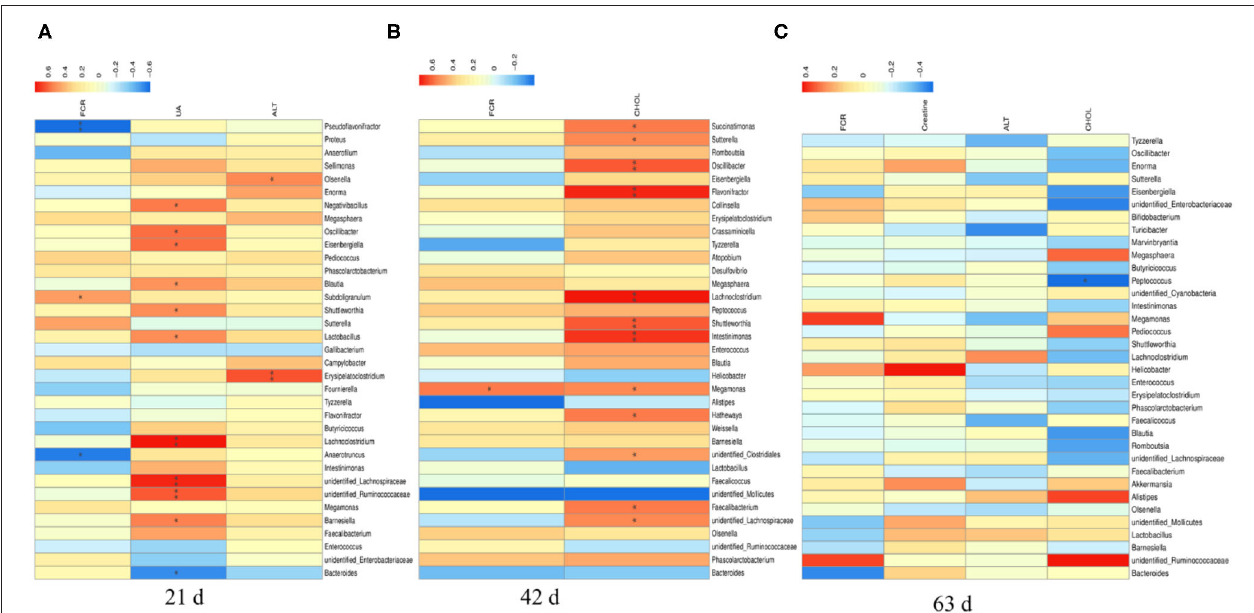
FIGURE 7 | The Spearman correlation analysis of cecal microbial species at genus level with feed efficiency and plasma differential metabolites in yellow-feathered broilers. The overall feed efficiency, indicated by feed conversion ratio (FCR) at d 1–63, as well as the differential metabolites in the plasma at either d 21 (A) , 42 (B) , or 63 (C) were used to correlate the changes of cecal microbial species at genus level determined at corresponding phases. The heatmap with red indicated a positive correlation, while blue represented a negative correlation. UA, uric acid; ALT, alanine transaminase; CHOL, cholesterol. * P < 0.05 and ** P <